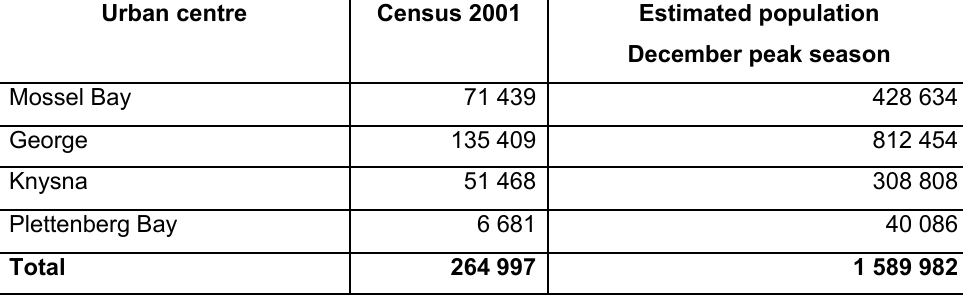
Table 2. Estimated December population figures in the major urban centres along the Garden